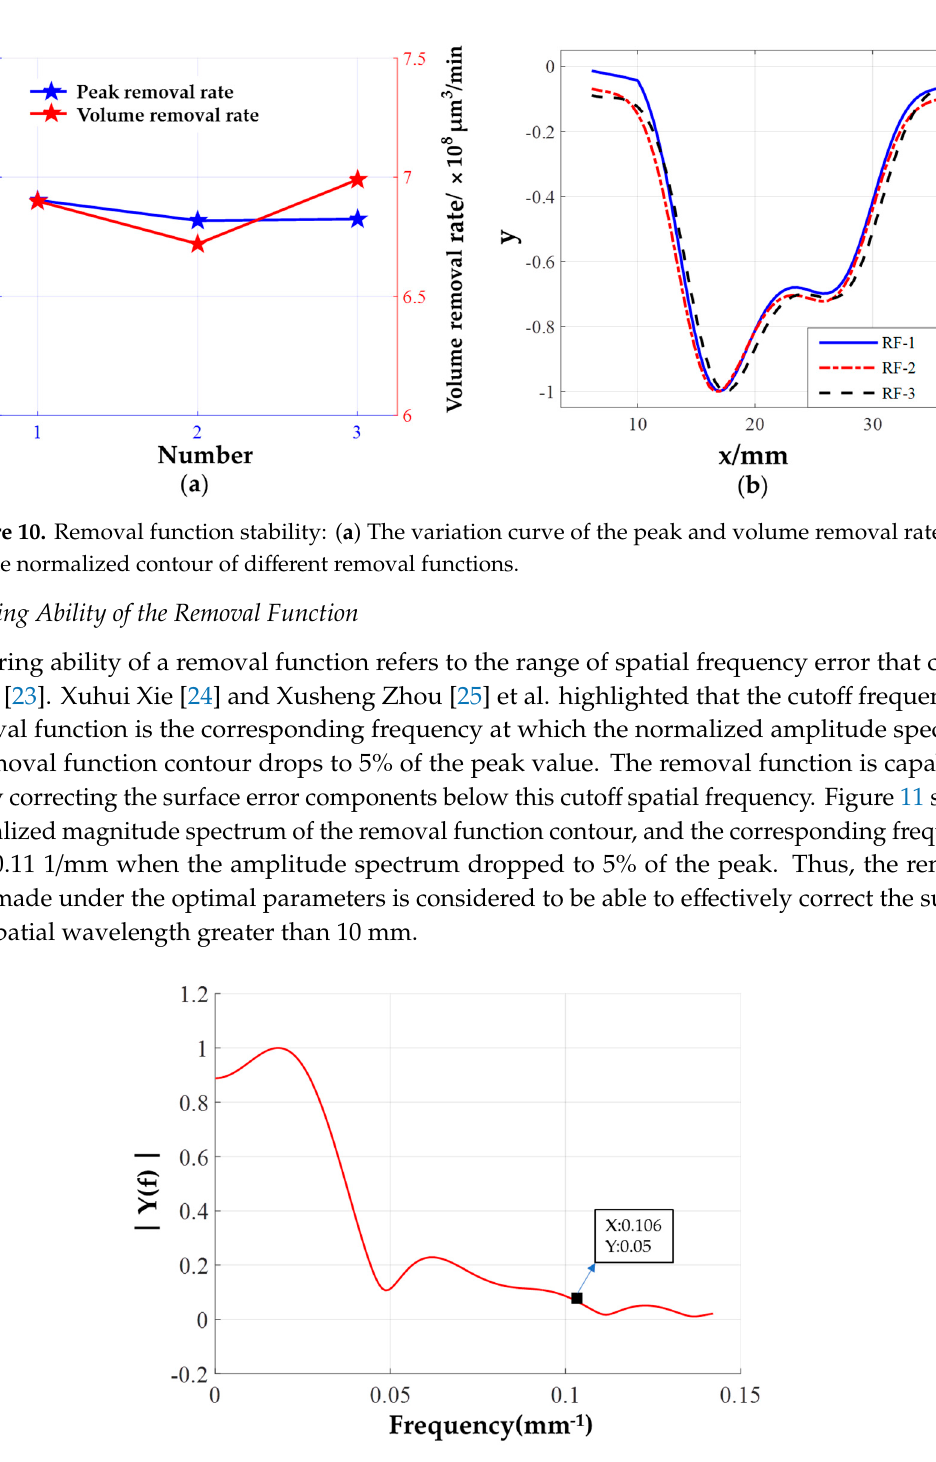
10 of 17 Figure 9. Removal function under optimization parameters: ( a ) Shape of removal function; ( b) normalized contour of the removal functions. 4.2. Stability of Material Removal Rate Removal function stability refers to the removal efficiency of removal function and the stability of geometric shape within a certain figuring time [22]. High material removal rate stability in a long-time polishing process is necessary for deterministic figuring. To verify the stability and repeatability of the removal function, experiments on 45 steel cylindrical workpieces were performed three times under the optimal experimental parameters as listed in Table 2, and the polishing time for each experiment was 15 min. The 45 steel cylindrical workpiece was initially prepared by precision turning. The variation curves of the peak and volume removal rate of different removal functions are plotted in Figure 10a, the stability of the volume removal rate is about 3.02%, and the stability of the peak removal rate is about 3.93%. The removal function profiles at their axially symmetric positions are extracted to compare their contour shape. Figure 10b shows the normalized profiles of different removal functions under the same parameters, and RF-X represent different removal functions in the plot. The ratio of the maximum deviation of the contour